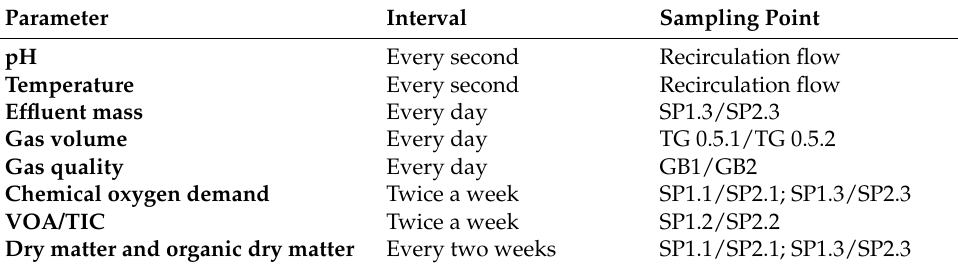
Table 2. Analyzed parameters, intervals, and sampling